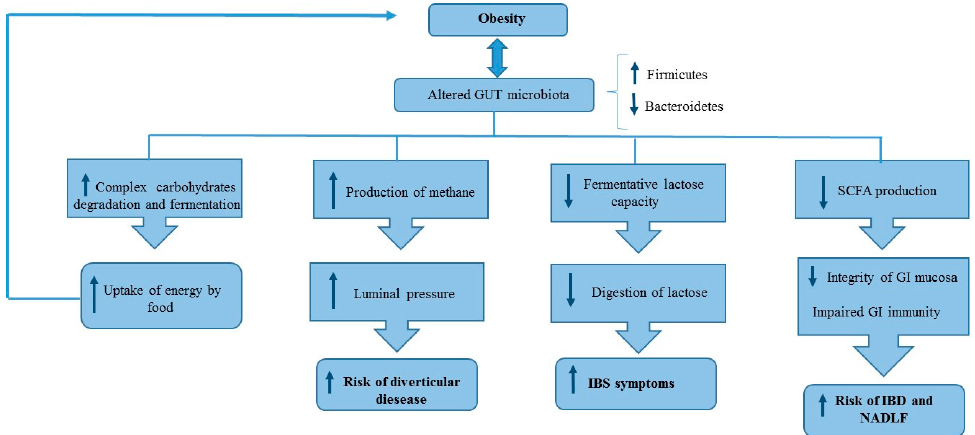
Figure 2. Relationship between altered microbiota composition and different pathophysiological mechanisms of GI disease in obese patients. SCFA: Short chain fatty acids, IBS: Irritable bowel syndrome, IBD: Inflammatory bowel disorders, NAFLD: Non-alcoholic fatty liver disease .